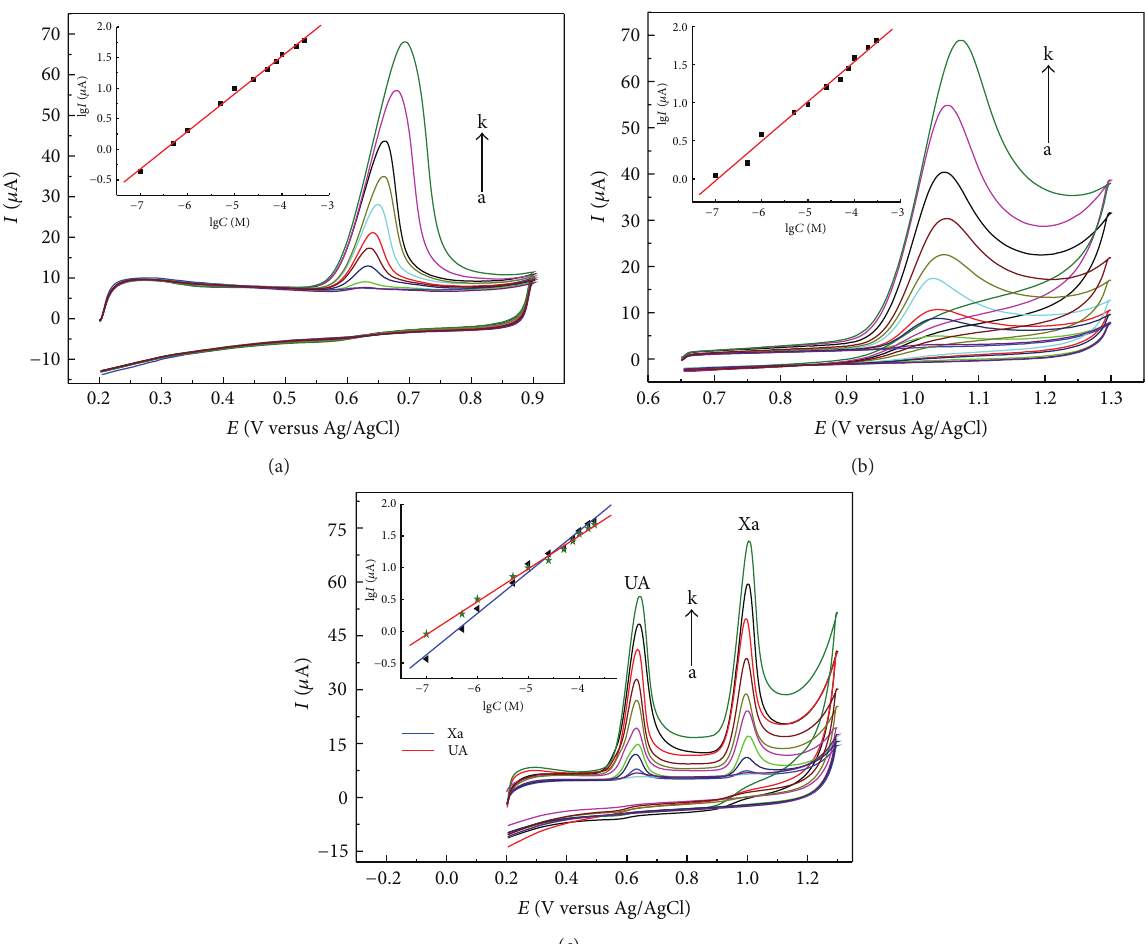
Figure 10: CVs of different concentrations of UA (a), Xa (b), and the mixture solution of UA and Xa (c) (from a to k: 0.08, 0.1, 0.5, 1, 2.5, 5, 7.5, 10, 25, 50, 75, 100, 200, 300, 400 𝜇 M) at a scan rate of 0.14V ⋅ s −1 with quiet time for 2 min. Insets show the calibration plots of lgI-lgC